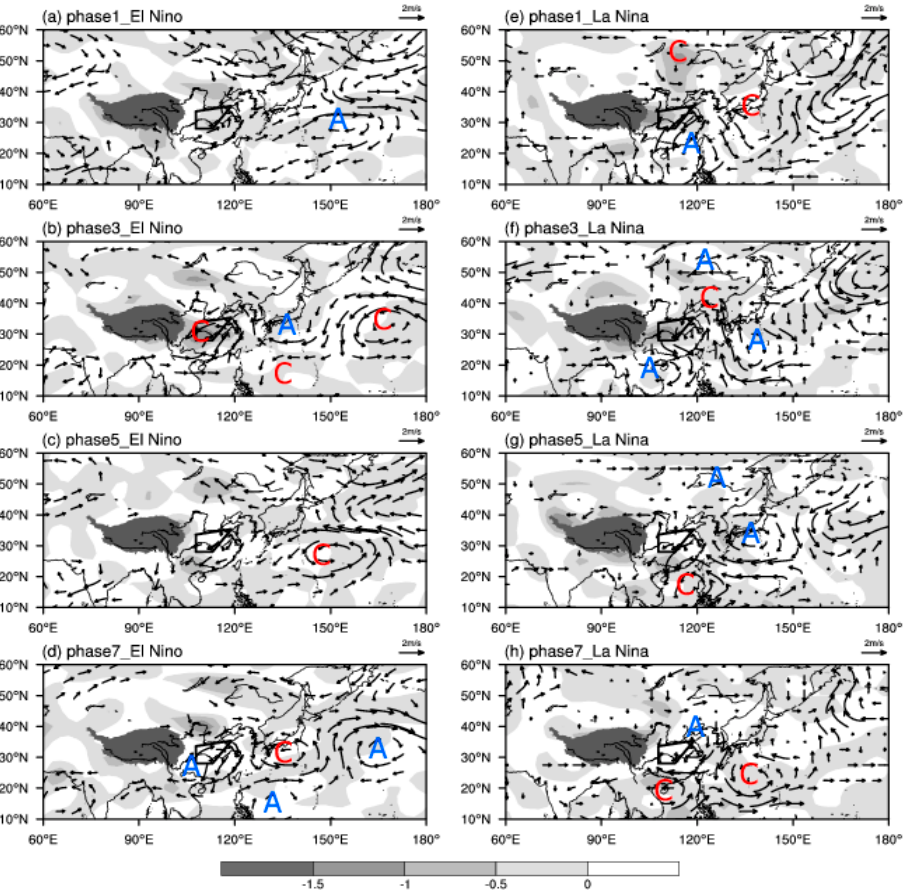
Figure 8. Same as Figure 5, but for the phase synthesis of 10–20 d low-frequency divergence fields (shaded areas represent convergent areas, units: 10 − 6 · s − 1 ) and low-frequency wind fields (vector, units: m · s − 1 ) at 850 hPa.